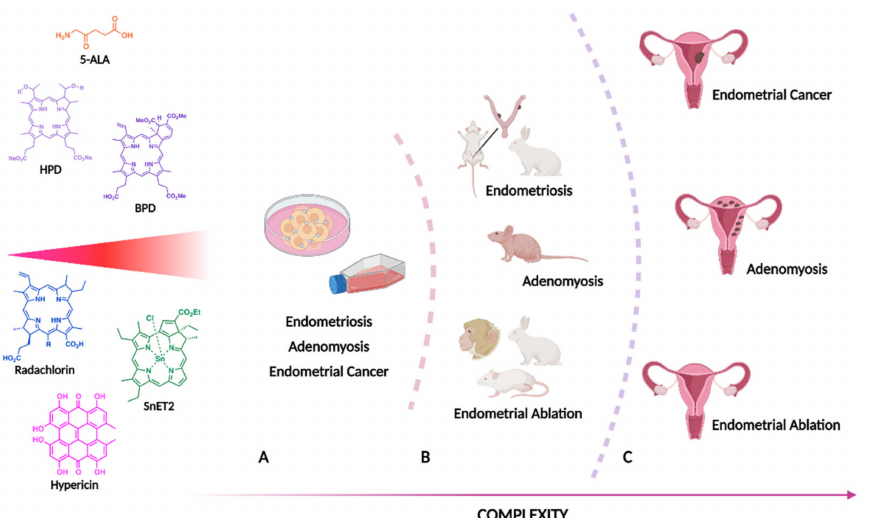
Figure 1. Applications of PDT on endometrial disease encompass in vitro ( A ), animal ( B ) and clinical trials ( C ). Current literature used several photosensitisers, including 5-aminolevulinic acid (5-ALA), hematoporphyrin derivative ( HPD ), benzoporphyrin derivative ( BPD ), radaclorin, tin ethyl etiopurpurin ( SnET2 ) and